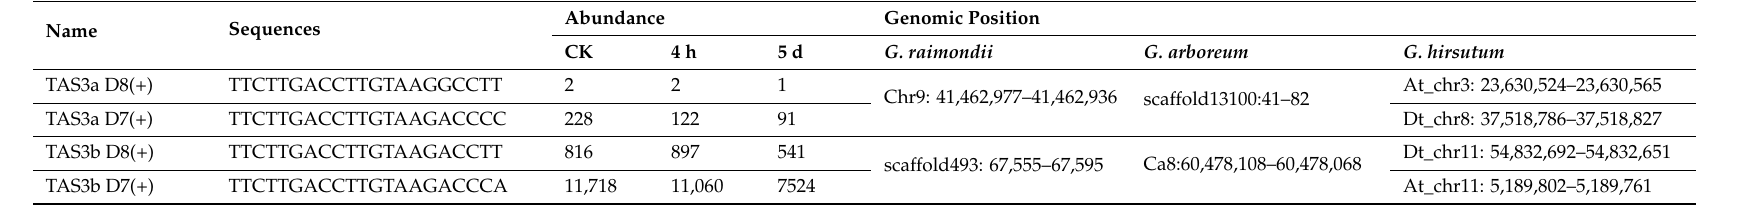
Table 4. Abundance of four tasiRNA-ARFs and genomic position of two TAS3 genes in three Gossypium species.